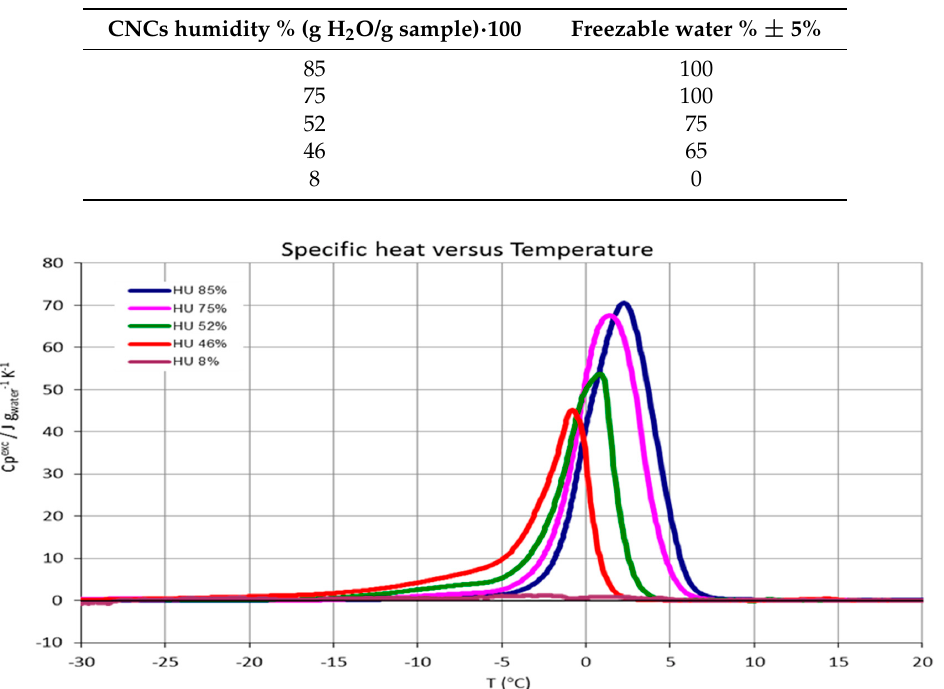
Figure 6. DSC measurements of CNCs at different humidity values.